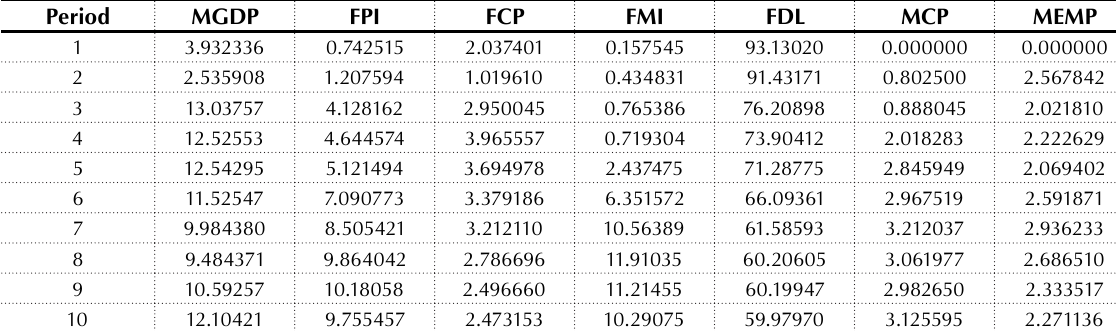
Table A3. Variance decomposition of FDL